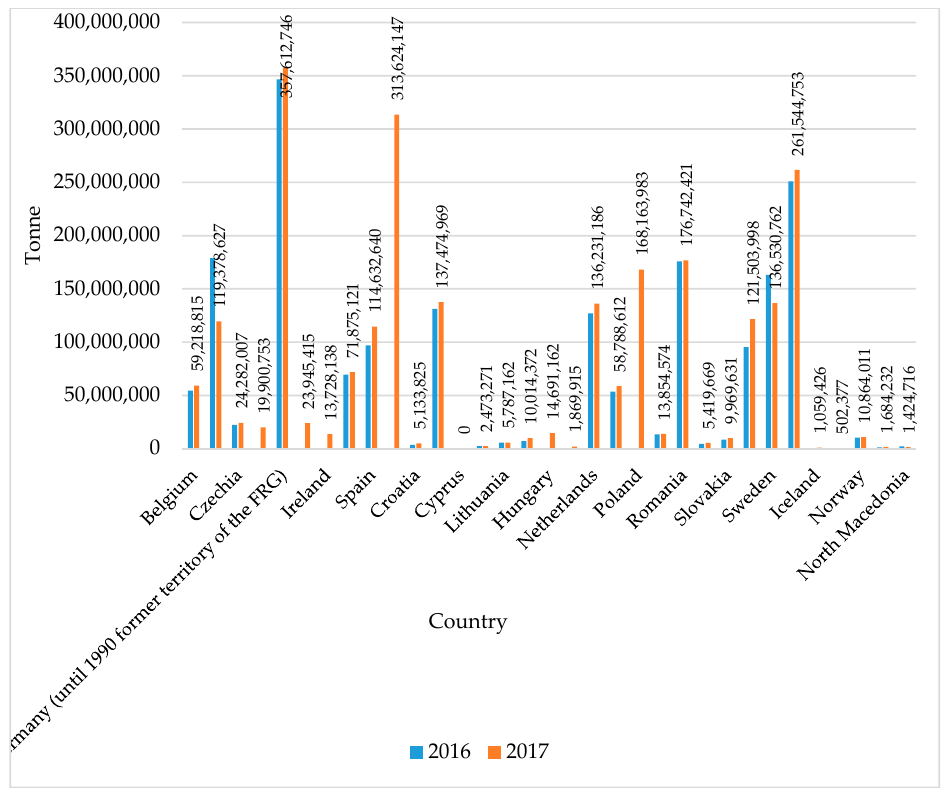
Figure 2. Situation of the number of employees in the main activities of the Romanian economy in the period 2017–2019 [44]. Processes 2020 , 8 , x FOR PEER REVIEW